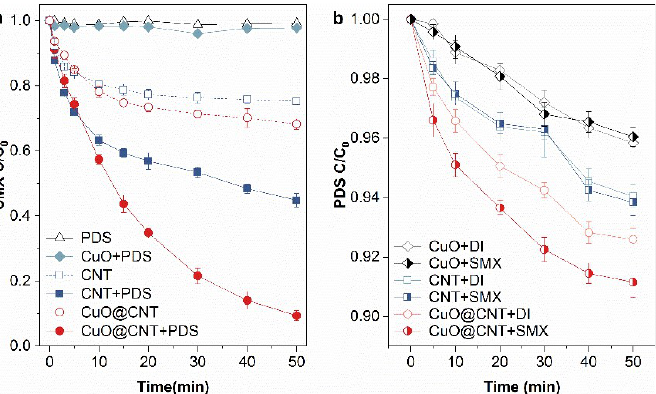
Figure 2. ( a ) SMX adsorption and degradation; ( b ) PDS adsorption and decomposition by CuO, CNT, and CuO@CNT. Conditions: SMX = 39.5 µM, PDS = 1.0 mM, Activator = 0.1